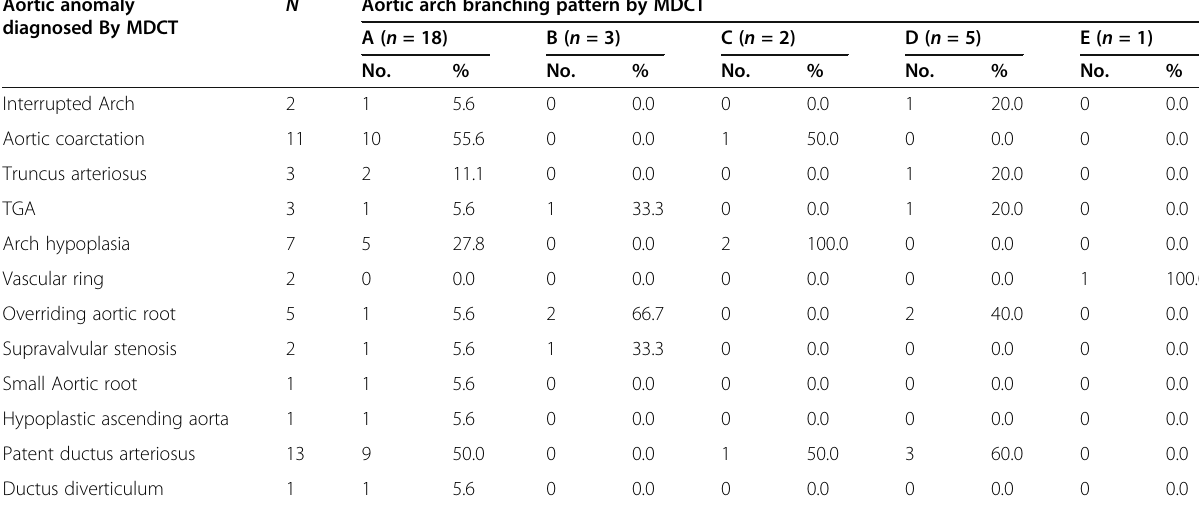
Table 5 Aortic arch branching patterns association with different thoracic aortic anomalies by MDCT Aortic anomaly diagnosed By